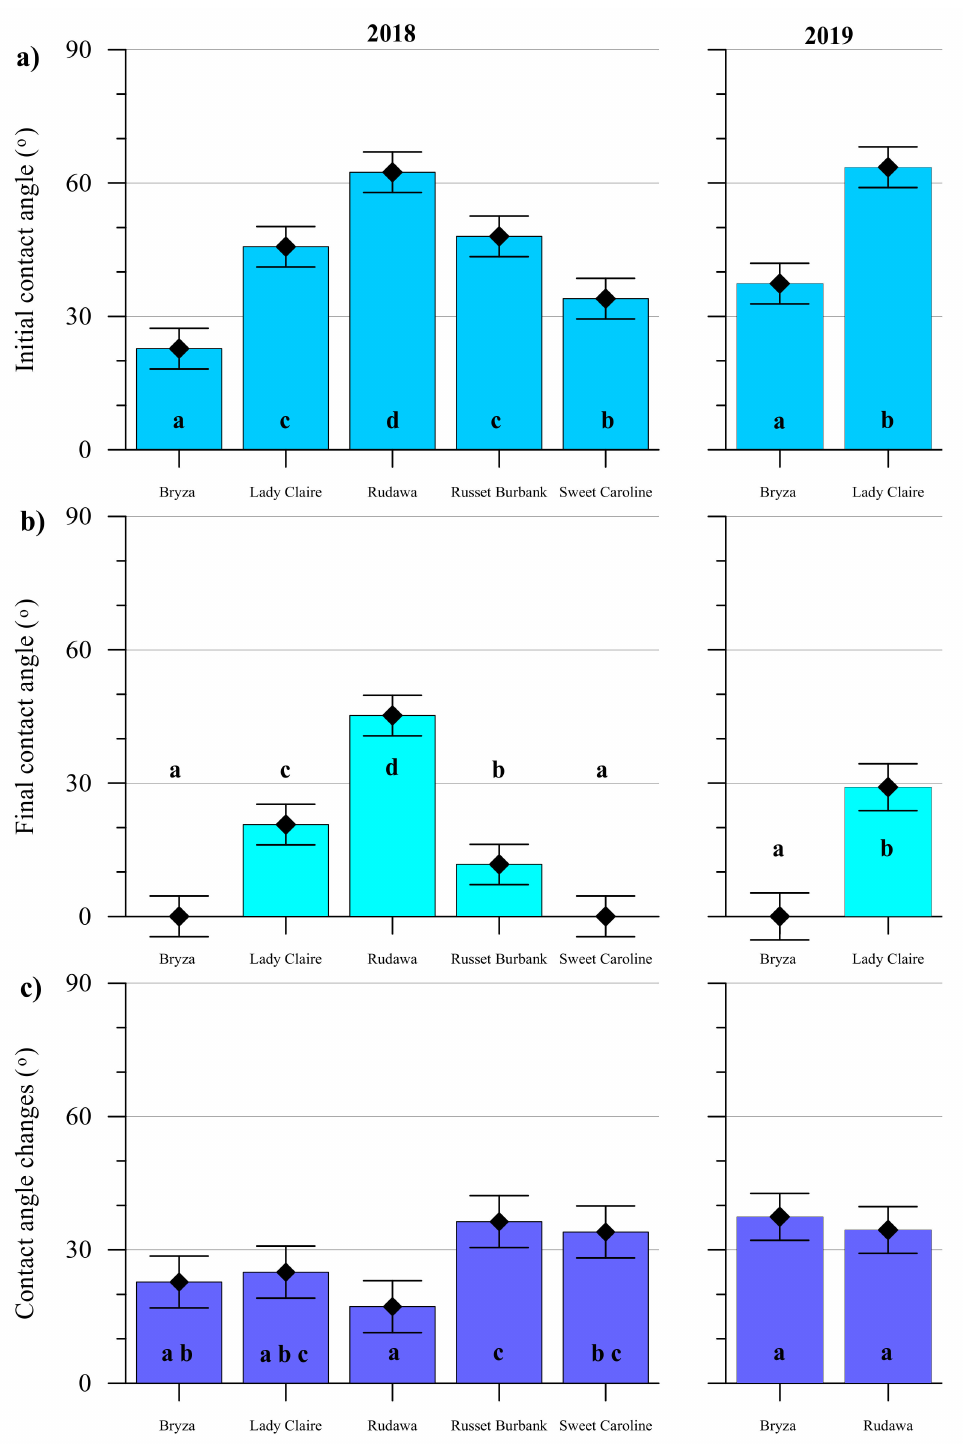
Figure 2. Contact angle measurement results for five potato cultivars in 2018 and two in 2019: ( a ) initial contact angle; ( b ) final contact angle; ( c ) change of contact angle values in time. The same letters denote homogenous groups based on two-factor analysis of variance at a 0.05 probability